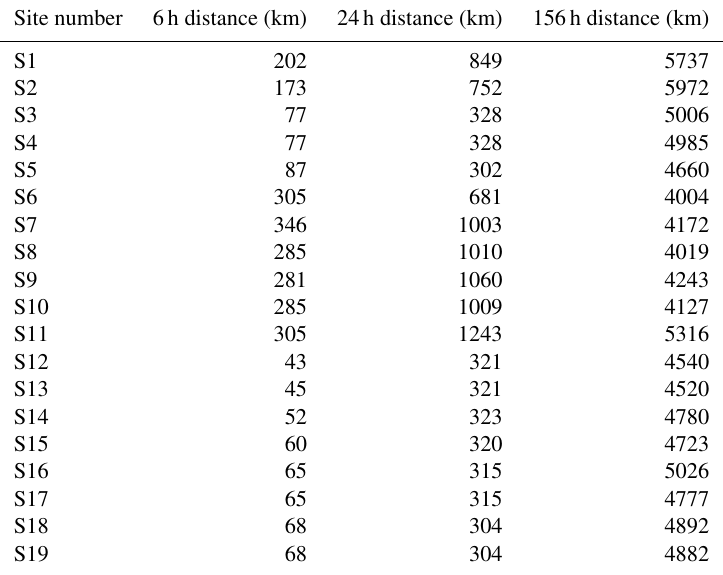
Table A3. Mean distance travelled by air masses for trajectory ensembles at each of the sites and at 6, 24 and 156h prior to sampling. Trajectories were initialized at a starting height of 2000m; starting heights of 1000 and 500m yielded similar